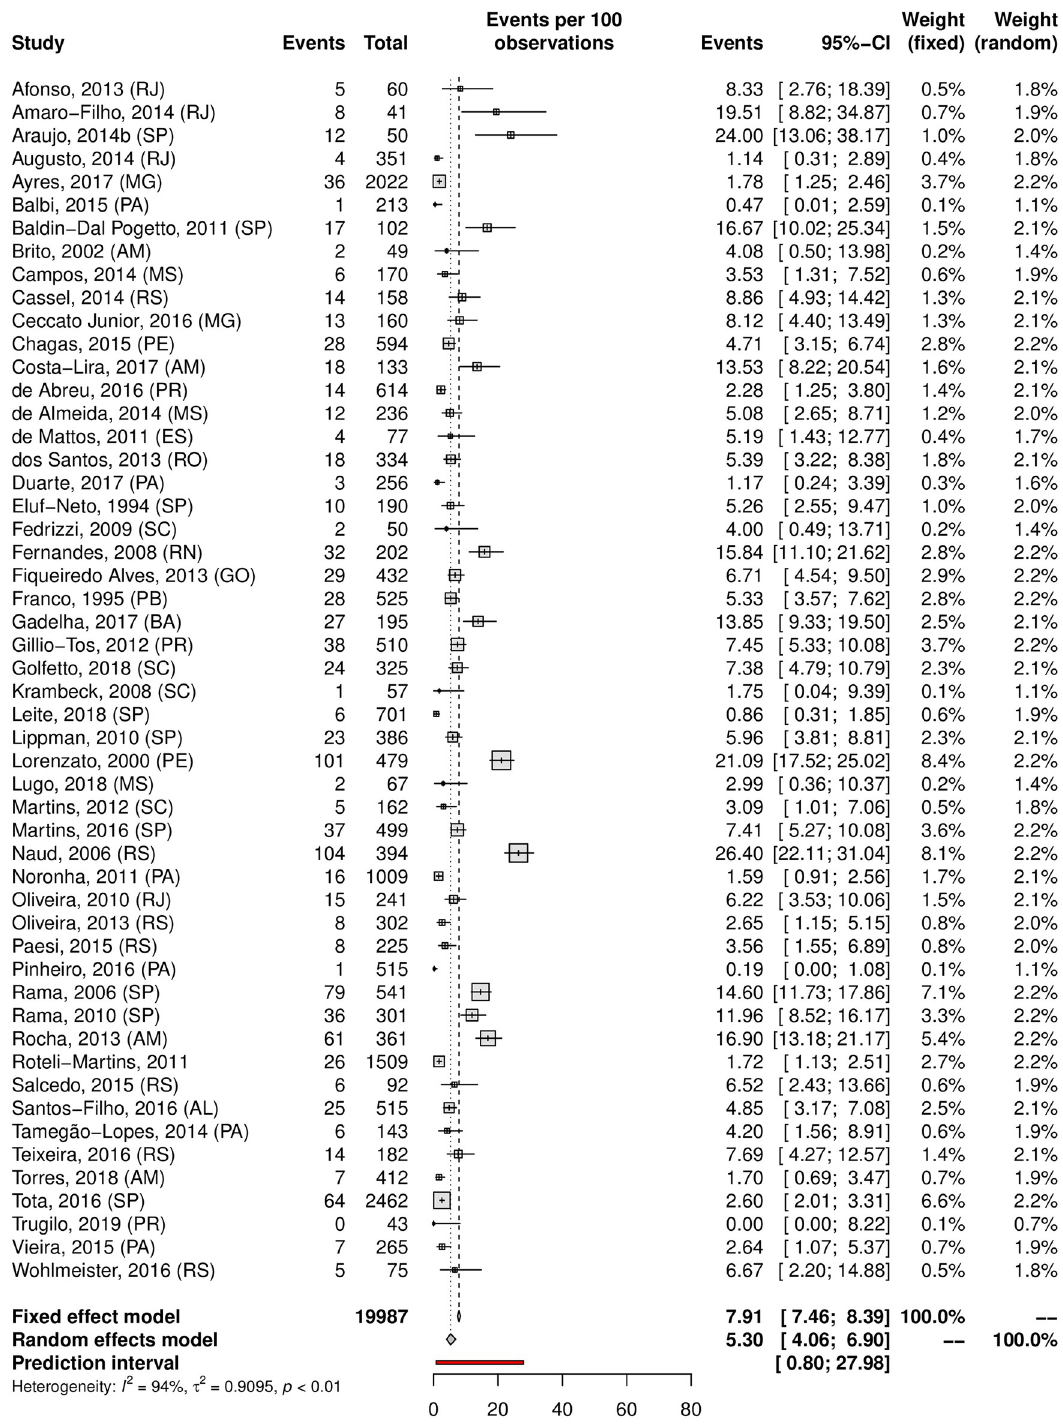
PLOS ONE | https://doi.org/10.1371/journal.pone.0229154 February 21,